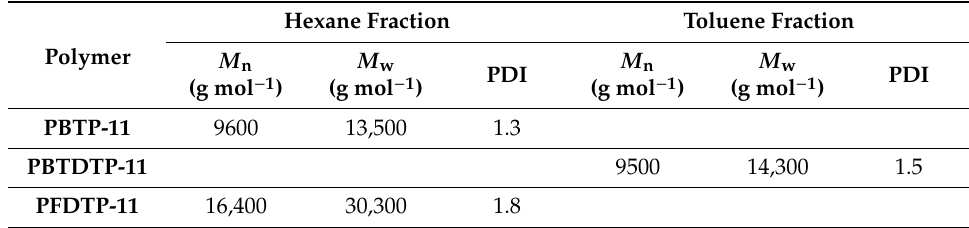
Table 1. The percentage yield, number and weight average molecular weights with